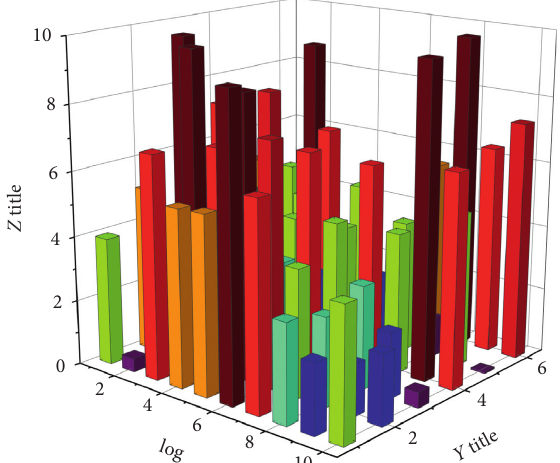
Figure 7: Statistics of lagging order of normal traffic system stimulus information layer and environmental and social